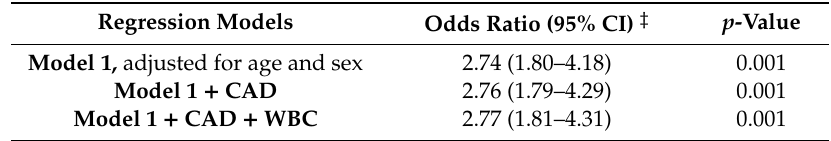
Table 2. Influence of individual factors on the odds ratios for DM-PAD per one standard deviation increase in plasma fatty acid-binding protein 4.